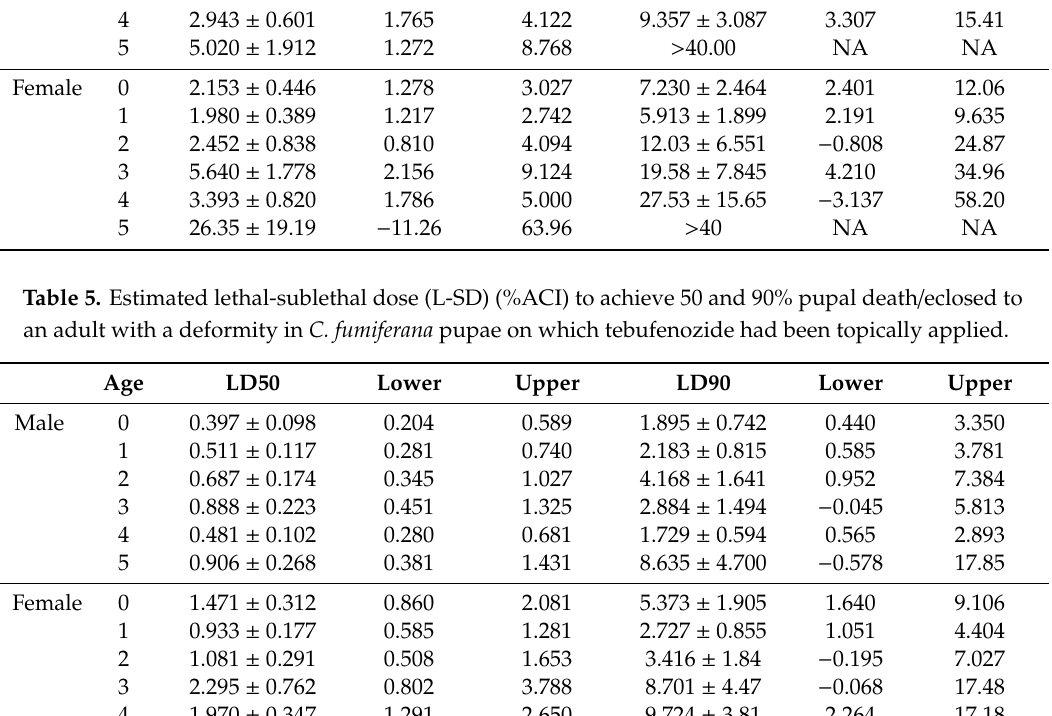
4-day old pupae treated with 0.25% ACI and 1.0% ACI. Significant reductions in mean longevity were also found in 0-day old males treated with 0.5% ACI and 1.0% ACI, and 2-day old males treated with 0.5% ACI. Treatment did not significantly reduce mean longevity in 3- and 5-day old male pupae. Mean female longevity was significantly reduced only in 3- and 5-day old pupae treated with 1.0% ACI. The treatment of pupae with Triton-X solution was never observed to significantly lower mean longevity when compared to untreated